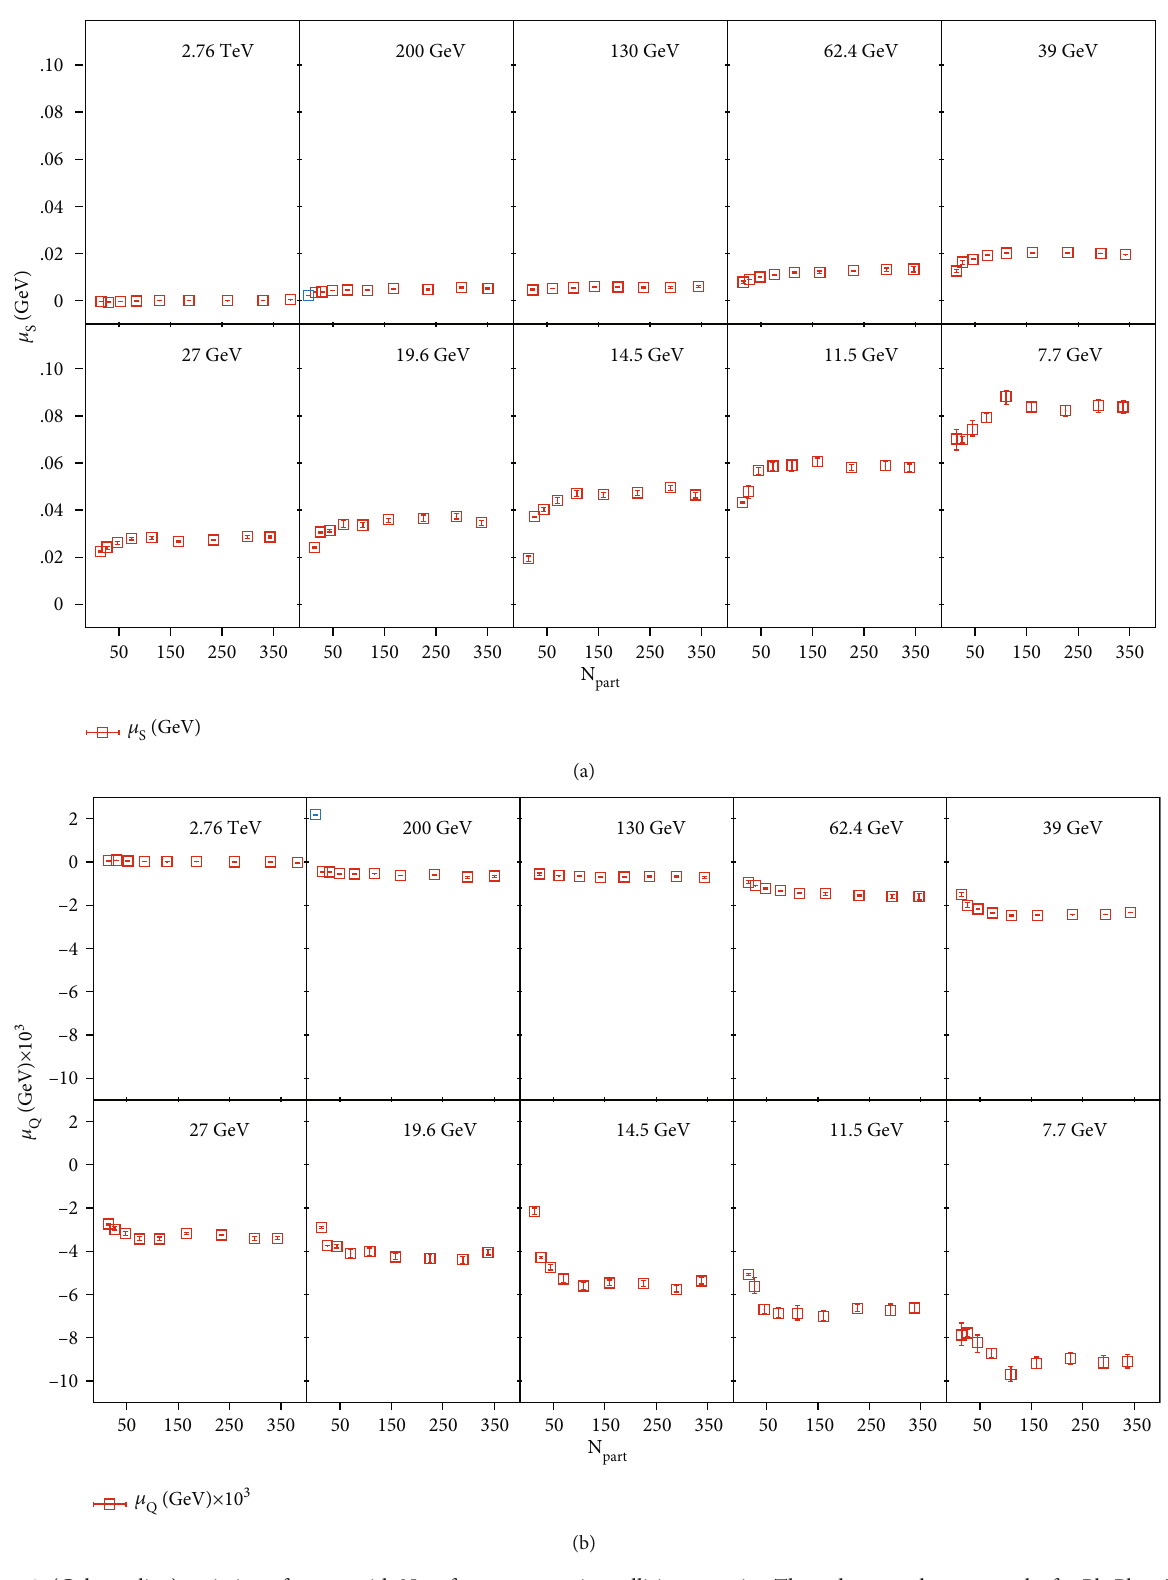
Figure 2: (Color online) variation of μ , μ with N part for representative collision energies. The red square denotes results for Pb-Pb at LHC S Q and Au-Au at RHIC and BES. Blue square points analysis for the p - p collision of